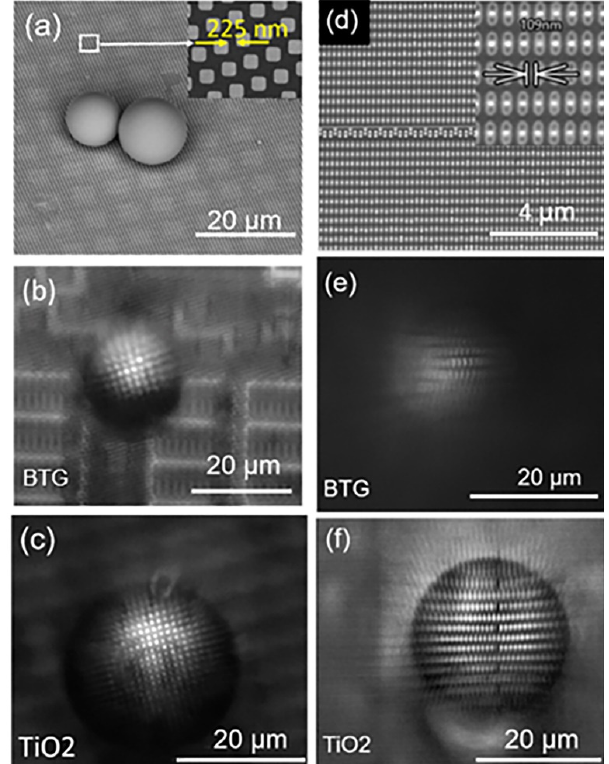
Figure 4. ( a ) SEM image of Meta-TiO 2 microspheres located on a wafer pattern of 400 nm features with a lattice spacing of 225 nm (Inset: Magnified image of the marked region). ( b , c ) Optical microscopic images of wafer pattern shown in ( a ) through BTG and TiO 2 microspheres, respectively. ( d ) SEM image of wafer pattern with 109 nm spacings, while the inset shows the magnified image of the same nanopattern. ( e , f ) Optical microscopic images of wafer pattern shown in ( d ) through BTG and TiO 2 microspheres, respectively.